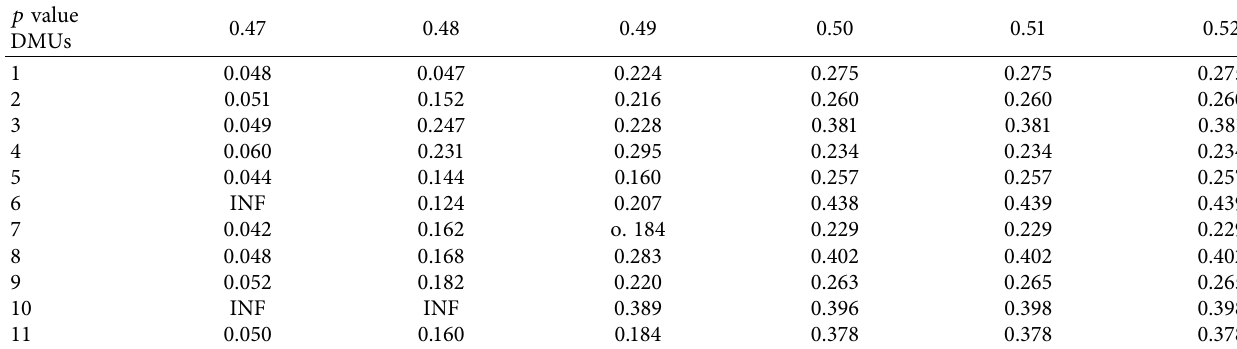
Table 8: The results of solving model